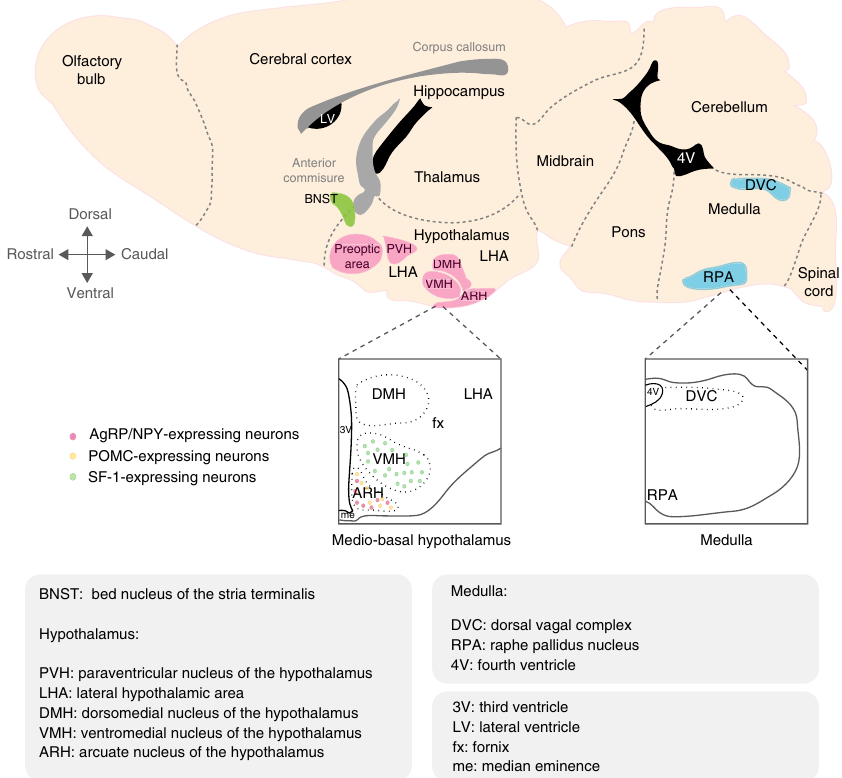
Figure 2 | Key brain nuclei and areas involved in CNS control of glucose homeostasis. Schematic representing a sagittal section of a mouse brain in which critical brain regions controlling glucose homeostasis and peripheral insulin sensitivity as well as brown fact activity are depicted. Three main regions are highlighted: the bed nucleus of the stria terminalis (BNST), the hypothalamus and the medulla. The hypothalamus contains the preoptic area, the paraventricular nucleus (PVH), the lateral hypothalamic area (LHA), the ventromedial nucleus of the hypothalamus (VMH, where SF-1-expressing neurons reside), the dorsomedial nucleus of the hypothalamus (DMH) and the arcuate nucleus of the hypothalamus (ARH) where AgRP/NPYand POMC neurons are located. In the caudal part the brain, the medulla contains key areas such as the dorsal vagal complex (DVC) and the raphe pallidus nucleus (RPA). 3V, third ventricle; 4V, fourth ventricle; fx, fornix; LV, lateral ventricle; me, median